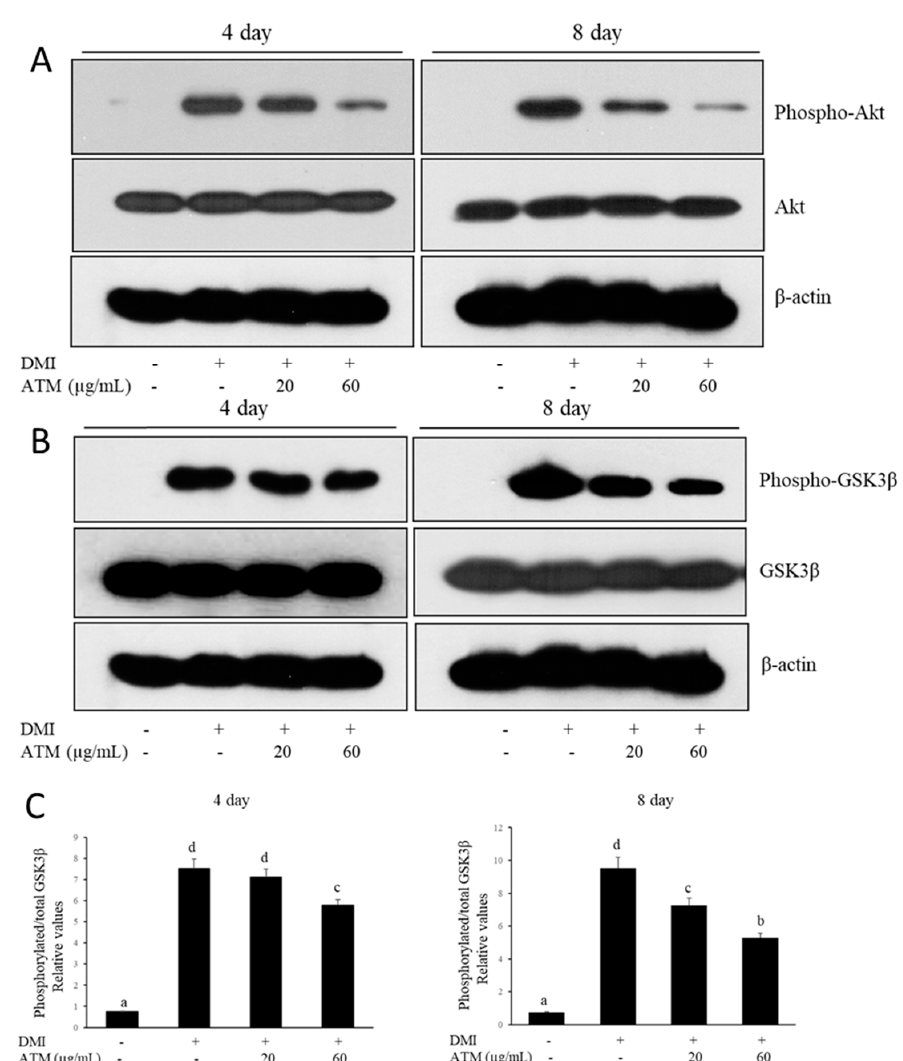
Figure 3. Effects of ATM on the Akt phosphorylation in 3T3-L1 adipocytes. ( A ) The phosphorylation of Akt in 3T3-L1 adipocytes. 3T3-L1 cells were differentiated with DMI in the absence or the presence of ATM for 4 or 8 days. The expression levels of Akt and phospo-Akt were measured in 3T3-L1 adipocytes by Western blot analysis. ( B ) Phosphorylation of GSK3 β in 3T3-L1 adipocytes. 3T3-L1 cells were differentiated with DMI with or without ATM treatment for four or eight days. GSK3 β and phospo-GSK3 β expression levels were measured in 3T3-L1 adipocytes by Western blot analysis. ( C ) The phosphorylation of GSK3 β was normalized to the total GSK3 β expression level. Bars with different letters are significantly different ( p < 0.05) as determined by Duncan’s multiple range test.